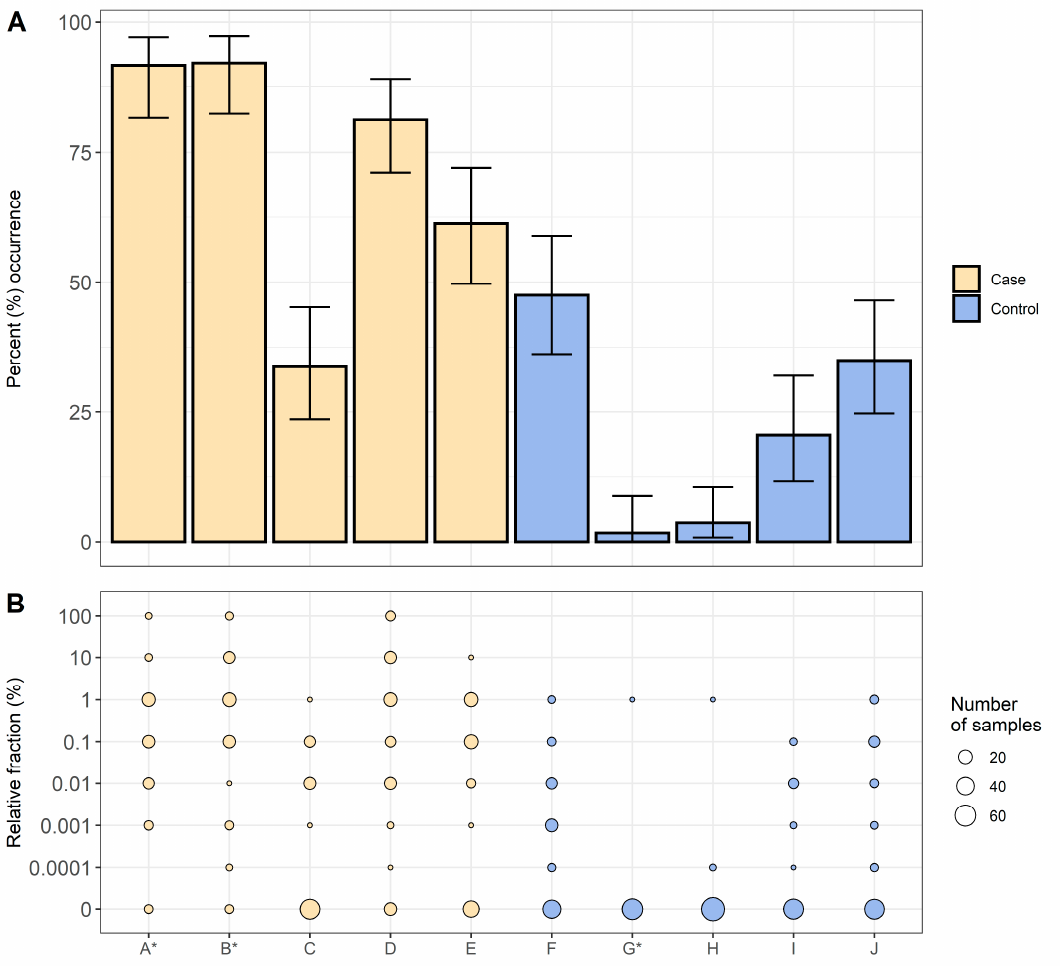
Figure 1. Occurrence and relative fraction of QREC among the tested samples from each herd. Case herds are coloured in yellow, and control herds in blue. Plot A presents the occurrence of QREC for each herd (x-axis) with 95% confidence intervals. Plot B presents the relative fraction of QREC among the total E. coli detected in the samples. The point size represent the number of samples with the respective QREC fraction. * herd is lacking samples from fattening pigs.